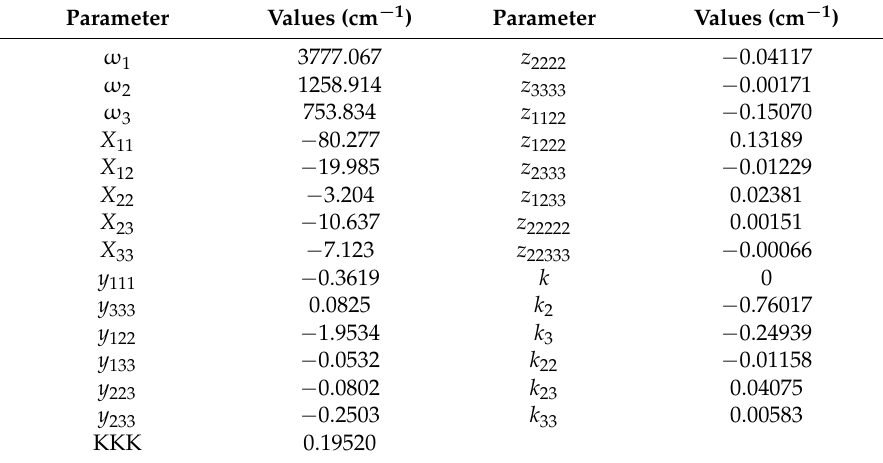
Table 1. The coefficients of the vibration Hamiltonian of the HOCl non-integrable system.